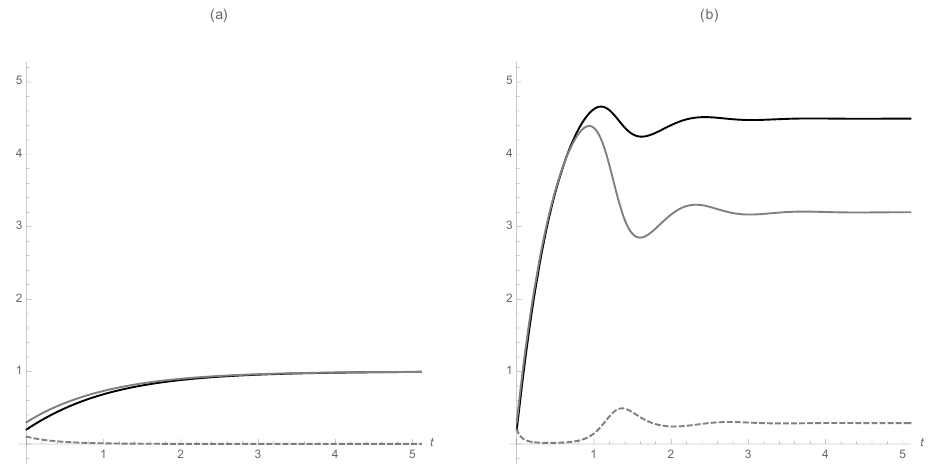
Figure 2. ( a ) The disease dies out. ( b ) The disease is endemic in the population at a constant rate. (In the figure S is in black, I is in gray, and R is